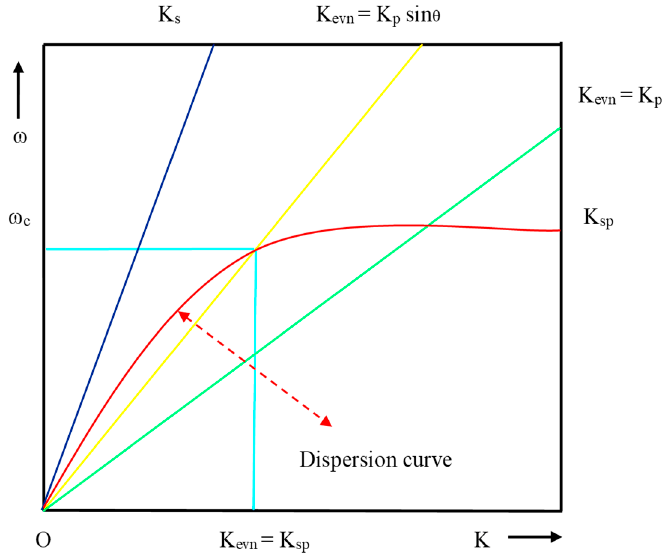
Figure 7. Dispersion curve for direct light, EW and SPW.